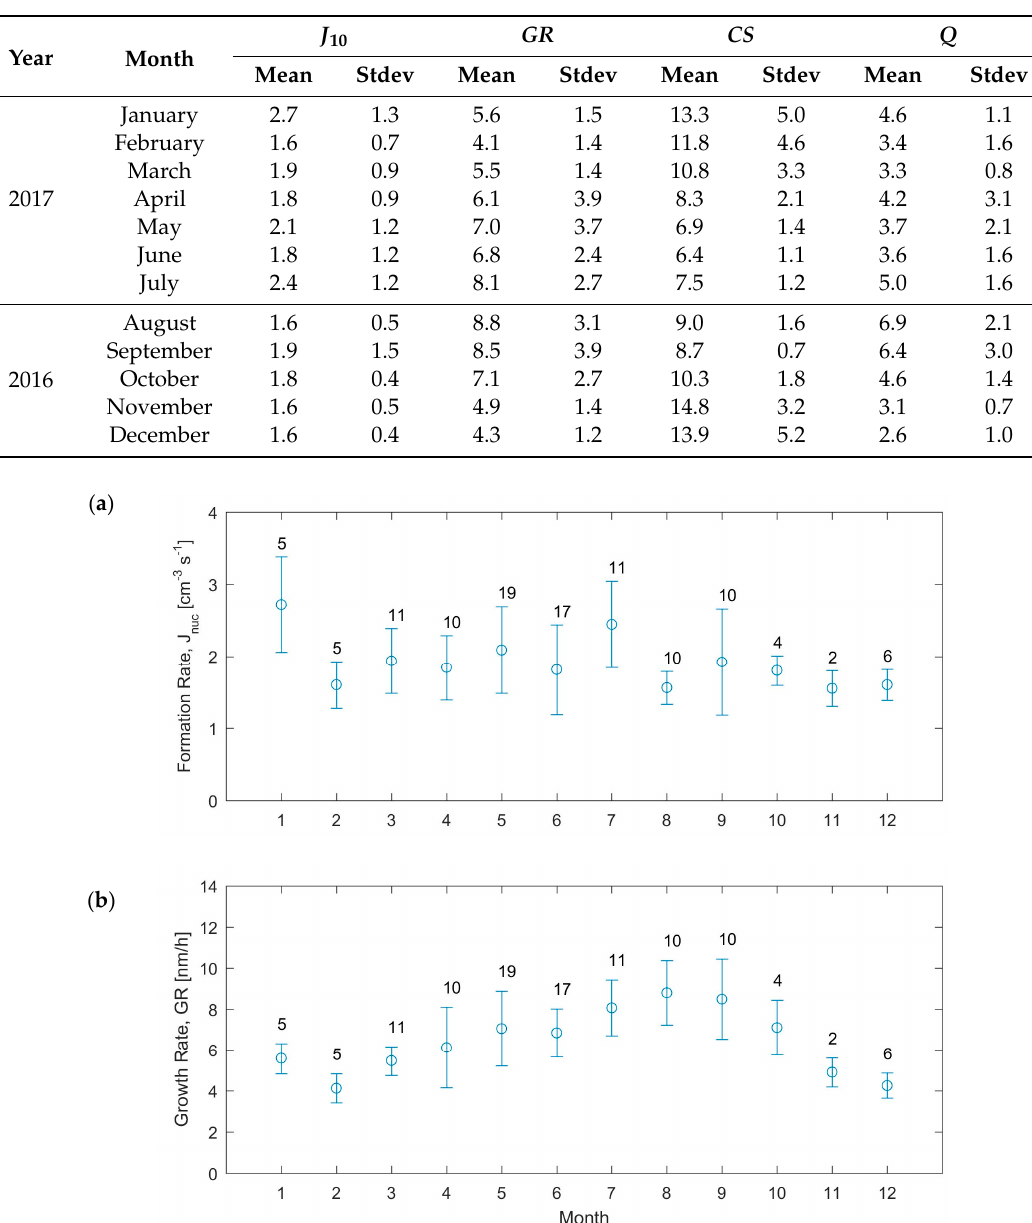
Table 2. Formation rate ( J 10 [particles / cm 3 s]), growth rate ( GR (nm / h)), condensation sink ( CS